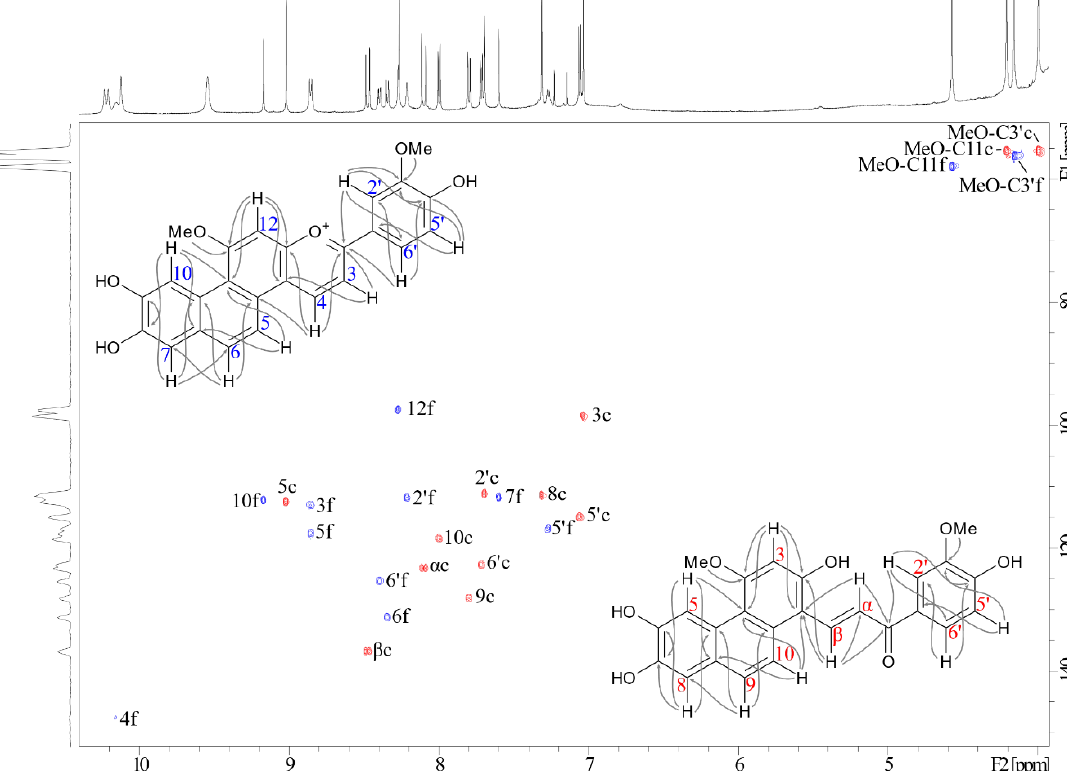
Figure 1. Heteronuclear single quantum coherence (HSQC) nuclear magnetic resonance (NMR) spectrum of Sphagnorubin C ( 1 ) in pure deuterated dimethyl sulfoxide ( d -DMSO) after equilibration for 24 h, showing the 1 H- 13 C cross-peaks of both the flavylium cation (blue) and the trans -chalcone (red) forms. The 1 H-NMR spectrum and the 13 C-NMR projection of 1 are aligned on the top and left axes, respectively. The flavylium cation (blue numbers) and trans -chalcone (red numbers) structures are supplied with arrows showing long-range 1 H- 13 C heteronuclear multiple bond coherence (HMBC) cross- peaks. The flavylium cation HMBC cross-peaks are collected from a sample of 1 dissolved in 5% deuterated trifluoroacetic acid ( d -TFA) in d -DMSO.